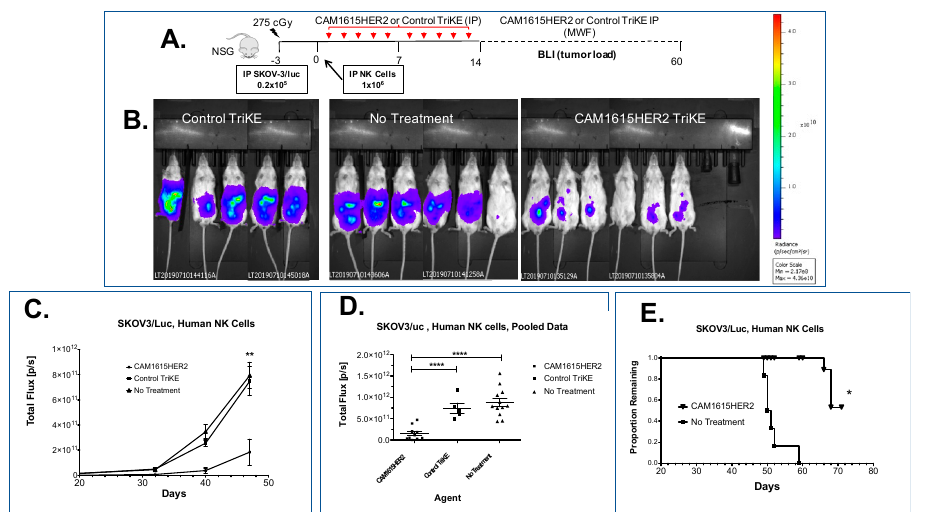
Figure 6. CAM1615HER2 TriKE mediates ovarian cancer control in the xenogeneic model. ( A ) Schematic of SKOV3-luc xenogeneic NSG mouse model with enriched NK cells. ( B ) Representative BLI images of different treatment groups (control TriKE, CAM1615HER2 TriKE, and no treatment) at about day 40 after the beginning of treatment. ( C ) Single experiment line graph of BLI images throughout the study until day 47, where the last BLI was taken ( n = 5–7 mice/group). ( D ) Scatter plot of pooled BLI data combining two experiments showing tumor load at day 47 of mice treated with CAM1615HER2 TriKE ( n = 10), control TriKE ( n = 5), or no treatment ( n = 12) when HER2 TriKE treatment is compared to control TriKE treatment or no treatment controls. ( E ) Kaplan Meier survival curve of confirmatory experiment demonstrating survival of animals within each treatment group ( n = 6). Error bars display mean ± SEM, and statistical significance was shown as * p < 0.05, ** p < 0.01, and **** p < 0.0001.